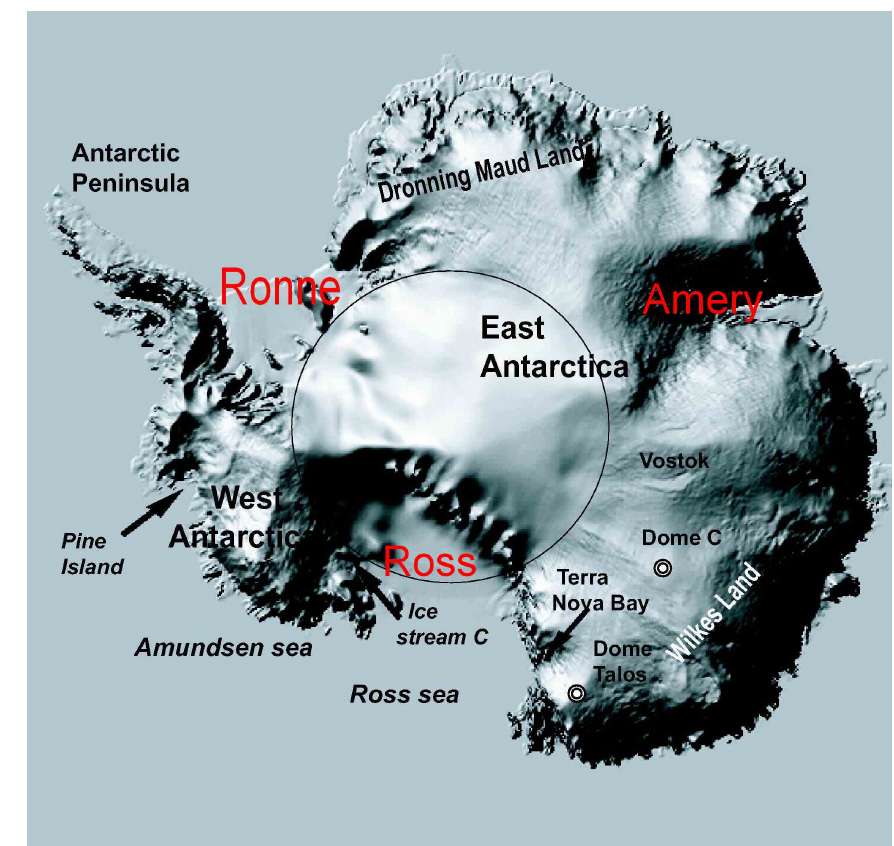
Figure 1. Map of the Antarctic ice sheet with the main places cited in the text. Ice shelf names are in